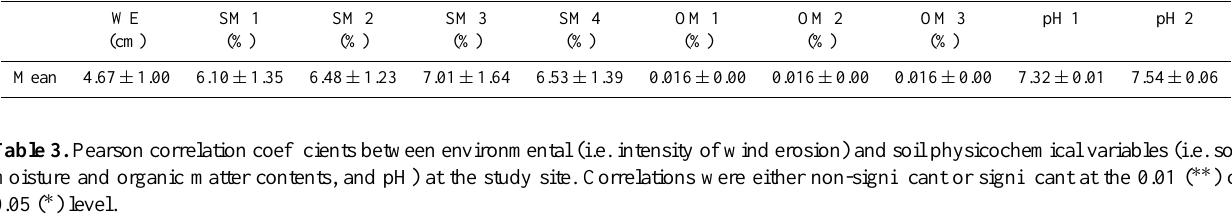
Table 2. Wind erosion intensity and soil physicochemical characteristics for the plots sampled in the transition zone. Values are mean ± 1 standard error (SE) of n = 27 for WE, n = 108 for each SM depth and n = 27 for each OM and pH depth. WE SM 1